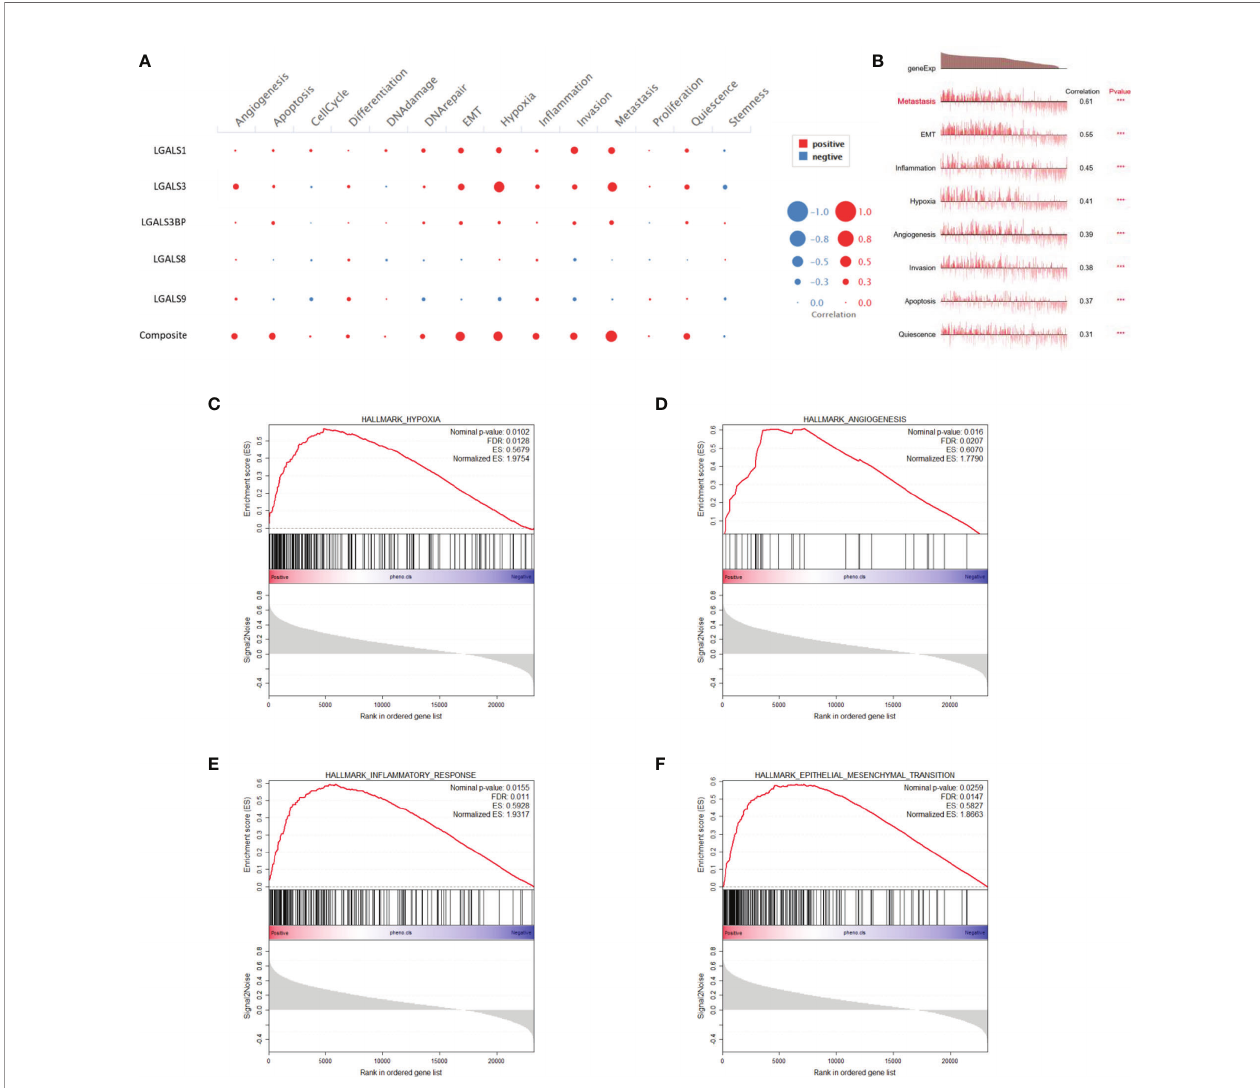
FIGURE 7 | LGALS expression correlates with EMT, hypoxia, in fl ammation, and angiogenesis of glioma in both single-cell and RNA-seq levels. (A) Correlations between each LGALS expression and several biological processes in single-cell RNA-seq level. (B) Correlations between LGALS signature and biological processes in single-cell RNA-seq level. (C – F) GSEA analysis of CGGA dataset shows that pathways containing hypoxia (C) , angiogenesis (D) , epithelial-to-mesenchymal transition (EMT) (F) , and in fl ammatory response (E) were activated in patients with high-risk scores. EMT, epithelial-to-mesenchymal